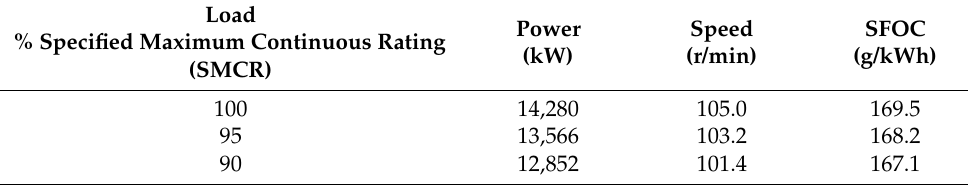
Table 8. S60ME-C8.5 Engine